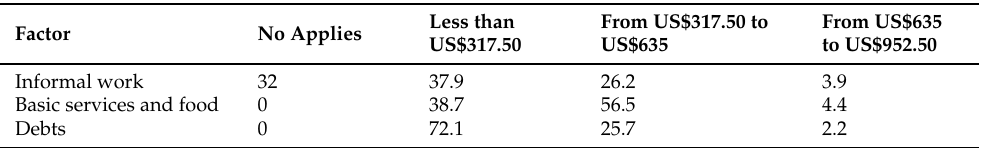
Table 2. Distribution (in percentage) of income from informal work and monthly expenses of unemployed